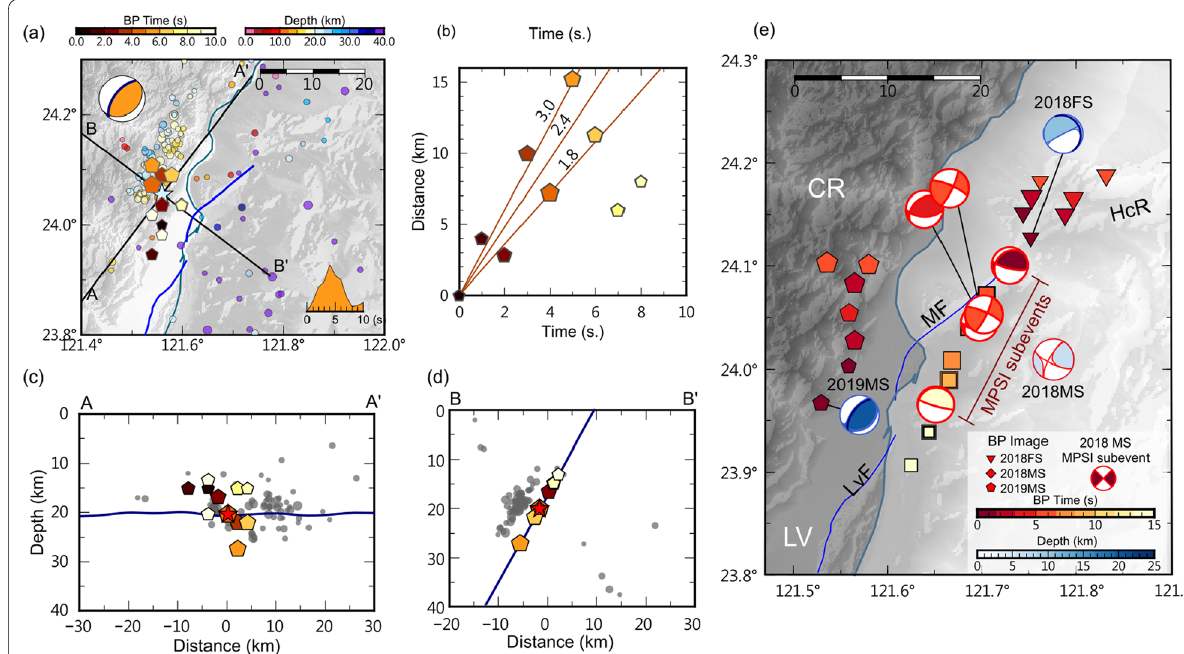
Fig. 4. 2D MUSIC BP results for 2019 mainshock and summary of ruptures associated with three strong earthquakes: a map‑view of 2D BP imaging along NW‑dipping fault plane, where seismic energy radiators (pentagons) are colored in accordance with elapsed time after onset of P‑wave arrival and aftershocks (small circles) are colored by focal depth ( b ) relationship between rupture distance and time, where blue lines indicate slopes representing rupture speeds and average rupture speed of 2019 mainshock was about 2.4 km/s; c , d profiles of BP results and aftershocks along cross‑sections parallel (AA’) and perpendicular (BB) to strike direction, where blue lines indicate fault plane projections and minor offset of 2–3 km exist between 2019 mainshock and aftershock distribution; e 2D BP imaging results of 2018 foreshock (triangles), 2018 mainshock (squares), and 2019 mainshock (pentagons), where spatiotemporal distributions of ruptures associated with the three events are denoted with the same color scale (red‑to‑orange) for the comparison of rupture durations of three events, the focal mechanisms of the 2018 mainshock’s MPSI result are also colored in accordance with subevents’ occurrence times, the AutoBATS MT solutions are colored by the focal